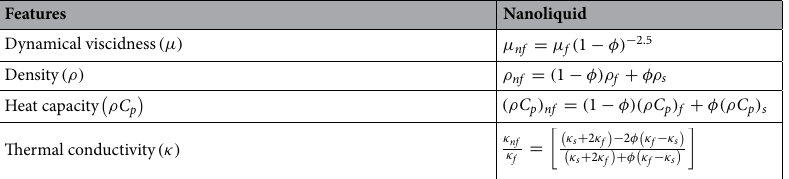
Table 1. Thermo-physical features for nanoliquids. φ is the nano solid-particle size coefficient. µ f , ρ f , ( C p ) f and κ f are dynamical viscidness, intensity, operative heat capabilities, and thermal exchange of the standard fluid respectively. The useless characteristics ρ s , ( C p ) s and κ s are the intensity, effective heat capacitance, and thermal conductance of the nanomolecules, correspondingly